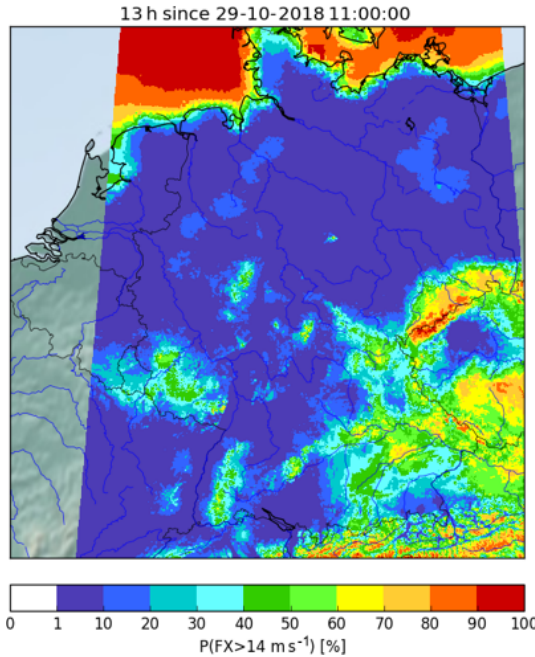
Figure 2. Probabilities of wind gusts higher than 14ms − 1 on a regular 1km grid over Germany; 13h forecast lead time from Ensemble-MOS for COSMO-DE-EPS from 29 October